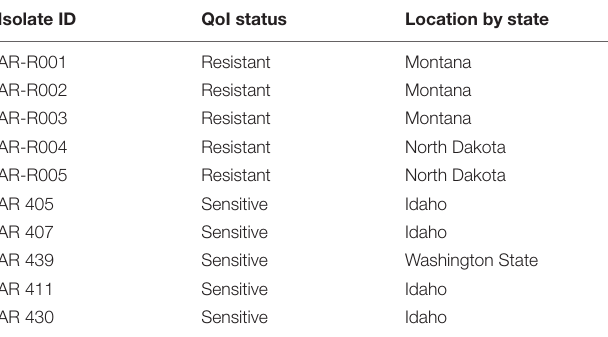
TABLE 3 | List of D. rabiei isolates used for the in vivo